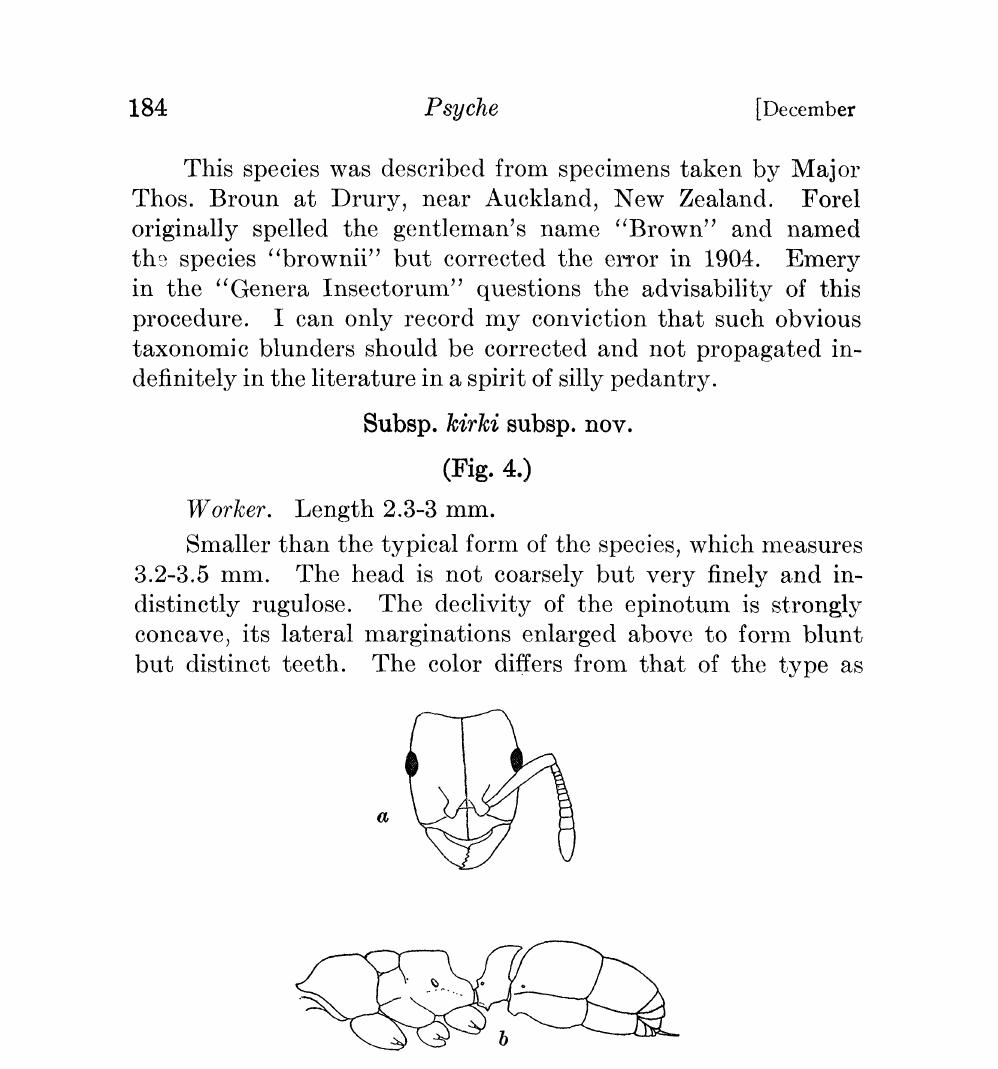
. Acanthoponera (Anacanthopo,nera) brouni Forel subsp, kirki subsp.nov, a, head Fig of worker from above; b, thorax and abdomen of same in profile; c, thorax and abdomen of ergatomorphic female in